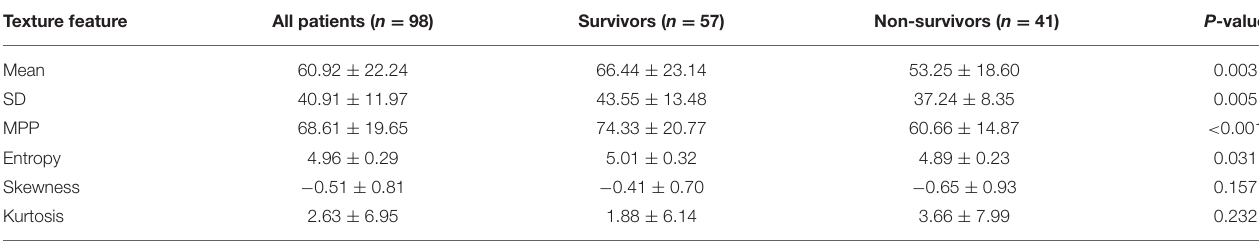
TABLE 2 | Comparison of CT texture features between survivors and